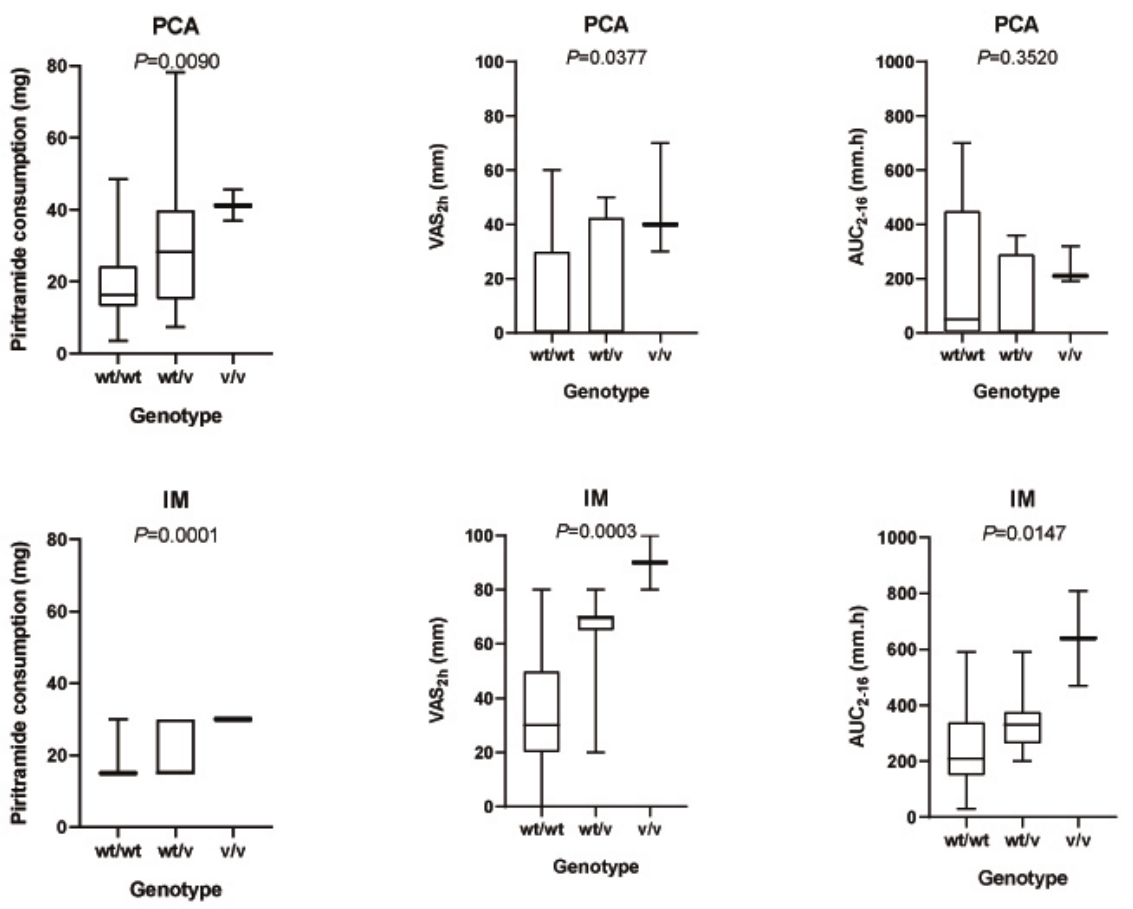
Fig. 1. Impact of OPRM1 (rs1799971) polymorphism on piritramide consumption and analgesic efficacy. PCA, patient controlled analgesia; IM, intramuscular injection; wt, wild-type allele; v, variant allele; VAS, visual analogue scale; AUC , area under the VAS-time curve from 2 to 16 2-16